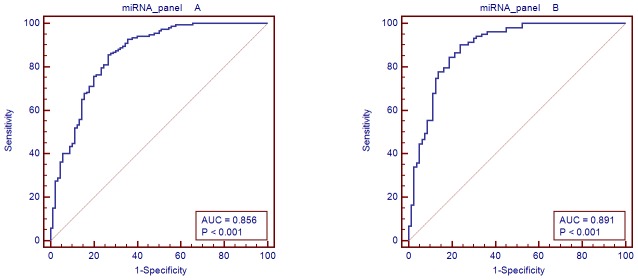
AUC of miRNA panel in the training set and validation set.A: AUC for the miRNA panel in the training set and B: AUC of the miRNA panel in the validation set.